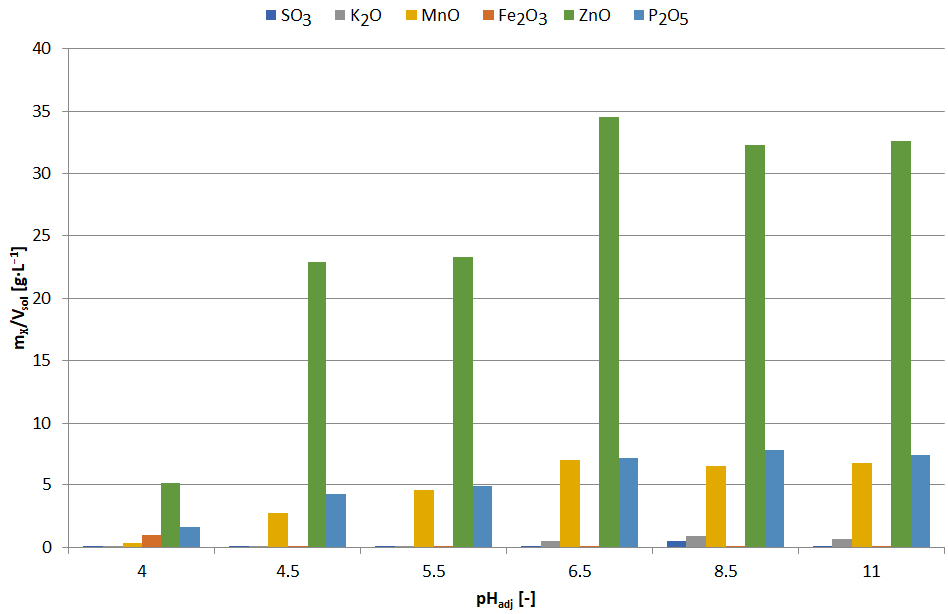
Figure 25. Effect of adjusted pH (pH adj ) amount of precipitated compound (m X /V sol ) as a result of precipitation by using Na 3 PO 4 from selective leaching solution .